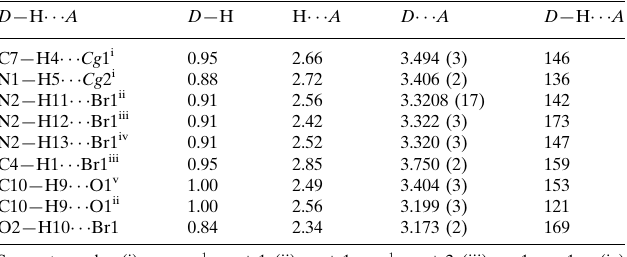
Hydrogen-bond geometry (A˚ , (cid:3)